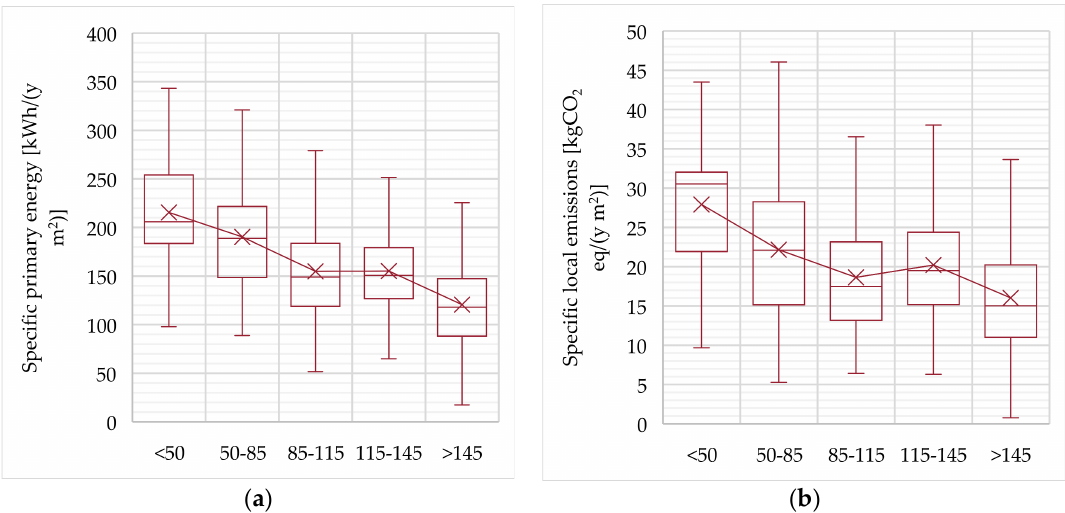
Figure 4. Key performance indicators: ( a ) specific primary energy; ( b ) specific local emissions.